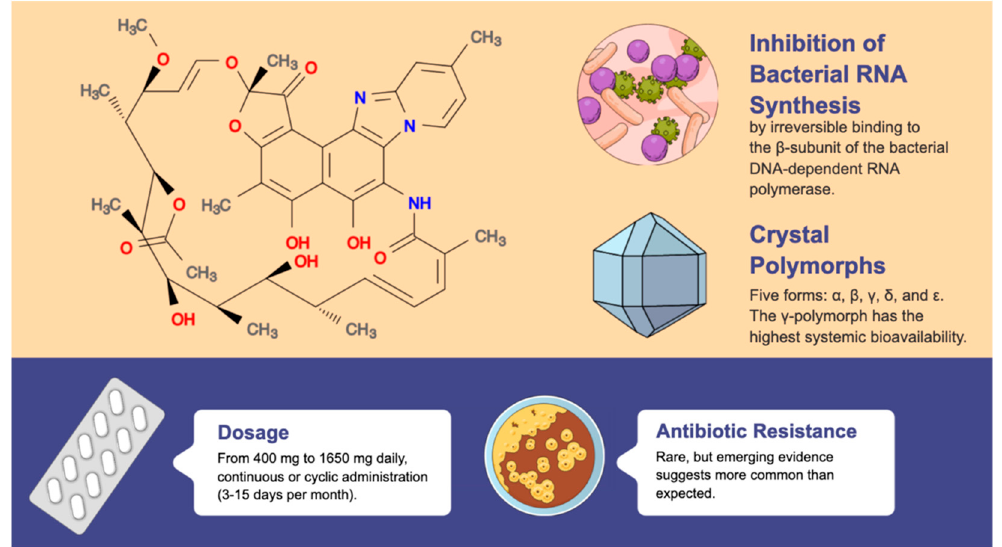
Figure 4. Rifaximin is a non-aminoglycoside semisynthetic antibiotic derived from the natural antibiotic rifamycin. Rifaximin has a largely water-insoluble, poorly absorbable nature, with a blood bioavailability of less than 0.4% after oral administration, with the γ -polymorph having the highest systemic bioavailability. Antibiotic resistance is rare, but more common than expected.